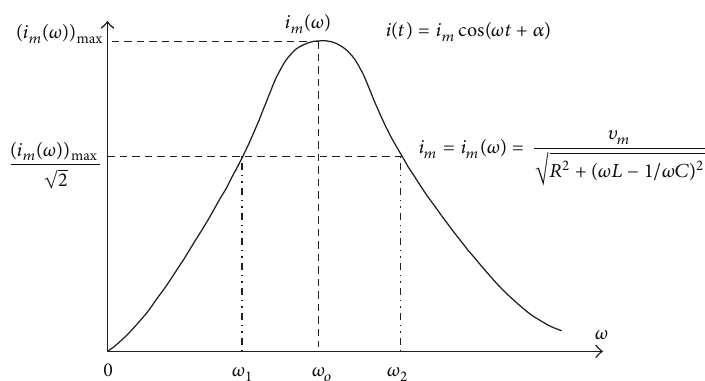
Figure 6: The resonance curve: Δ𝜔 ≡ 𝜔 2 − 𝜔 1 = 2𝛾 ; 𝑄 = 𝜔 𝑜 /Δ𝜔 .